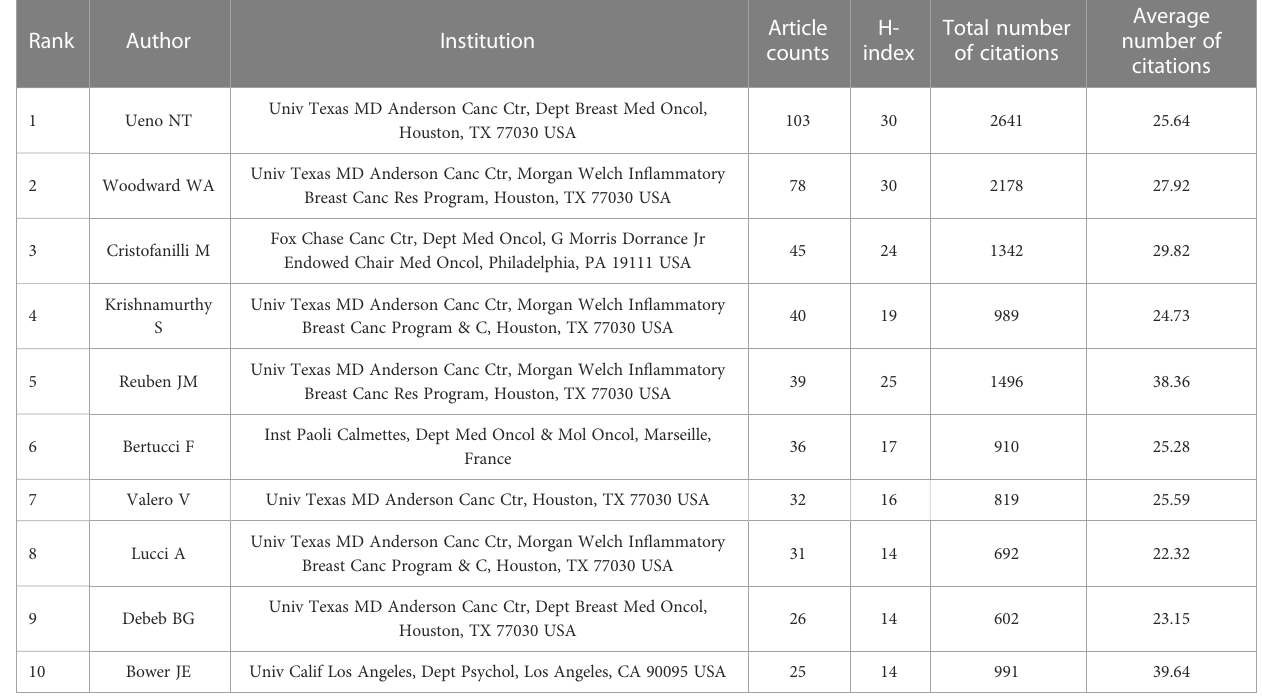
TABLE 4 The top 10 most productive authors contributed to publications about in fl ammation in breast